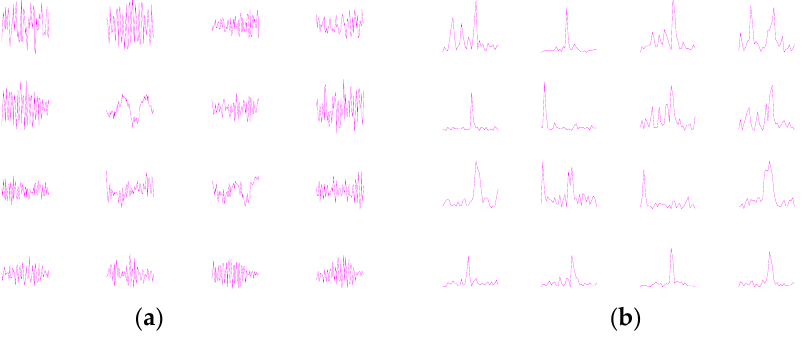
Figure 13. Visualization of convolutional kernels learned by ( a ) WDCNN and their ( b ) frequency-domain representation.